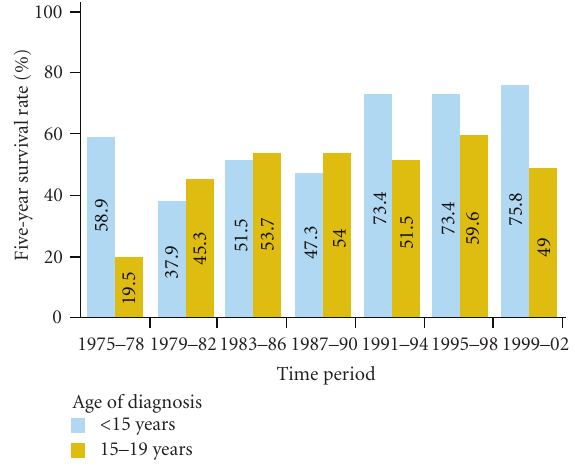
Figure 2: Five-year survival rates for Ewing’s sarcoma (EWS), 1975–2006. The 5-year survival rates for EWS among children and adolescents is shown by age group and time period of diagnosis from 1975 through 2002, with follow-up of survival through 2006; data are from the Surveillance, Epidemiology, and End Results 9 (SEER 9) registries (Reprinted with permission from Smith et al.